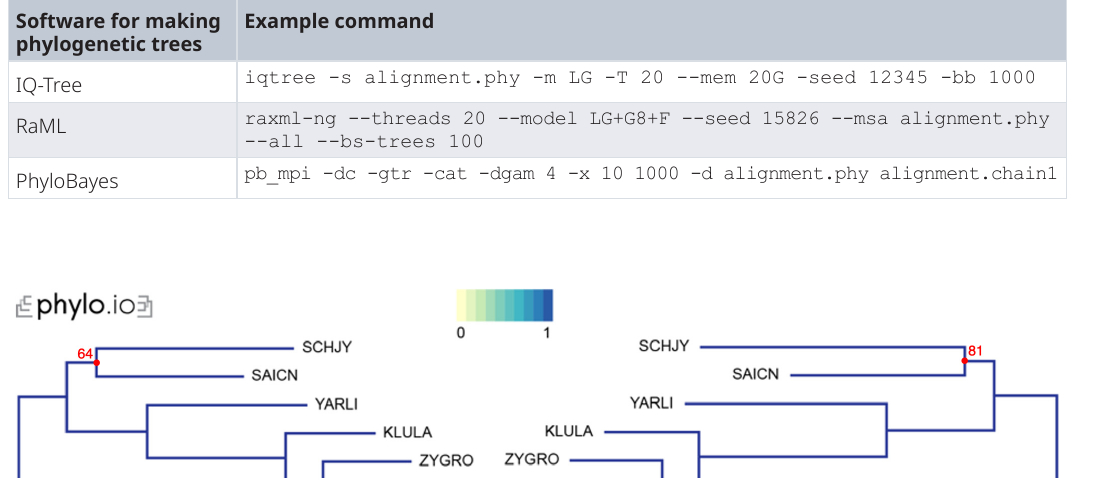
Table 2. Recommended software and example commands for computing a phylogenetic tree. Parameters, such as memory or threads, may vary based on size of dataset. Software for making phylogenetic